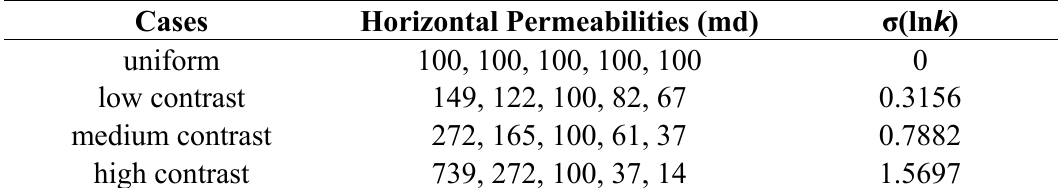
Table 1. Permeability of